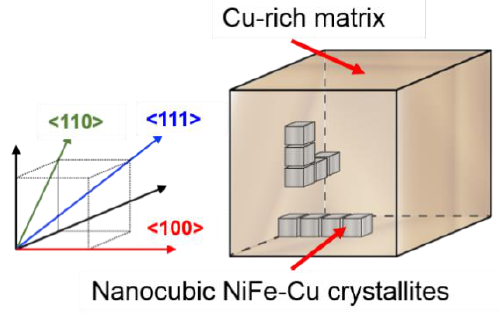
Figure 2. Schematics of the structure and crystal orientations of the Cu 75 Ni 20 Fe 5 sample. Table 1. Atomic compositions determined by energy-dispersive X-ray spectroscopy analysis using a scanning transmission electron microscope, magnetic moments per atom calculated from first principles analysis of the matrix, and nanocubic precipitates prepared from the base material of Cu 75 Ni 20 Fe 5